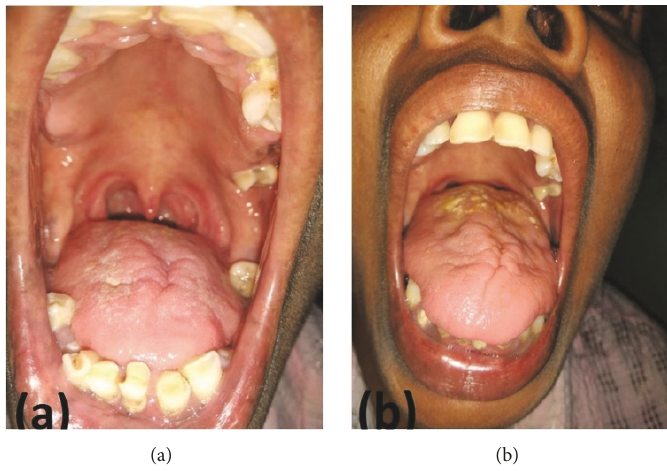
Figure 1: Bilateral tongue wasting: (a) resting position; (b) on